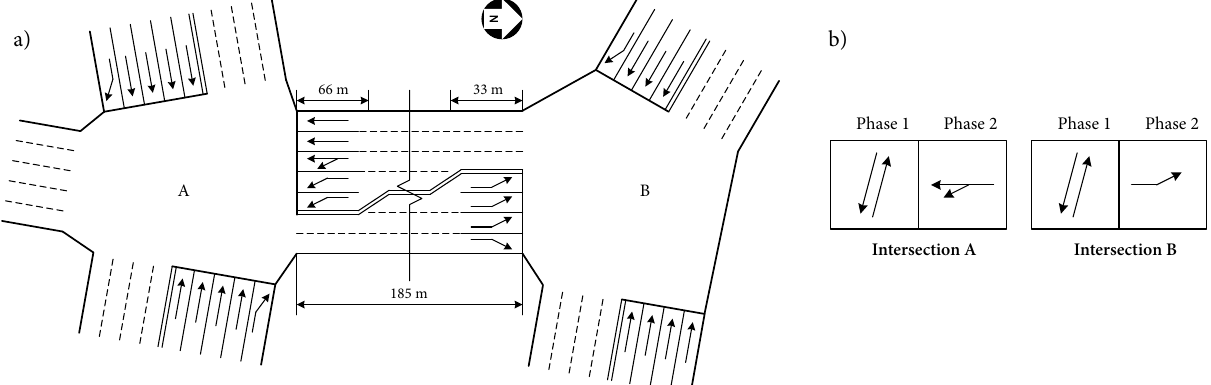
Figure 3. Geometry design and signal phasing for the study intersections: a – geometry design; b – signal phasing